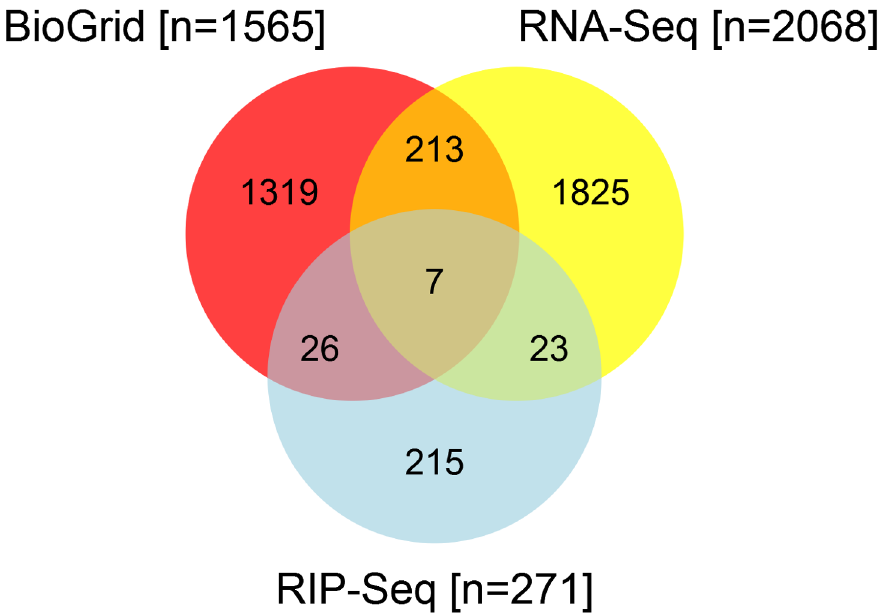
Fig 1. Venn diagram of RNA-Seq, RIP-Seq, and BioGRID reported ELAVL1 target genes. Results from the RNA-Seq and RIP-Seq experiments were compared to genes experimentally verified in the literature to interact with ELAVL1, as curated in the BioGRID database. Results from BioGRID were limited to genes with mouse orthologs to make the results more compatible with our